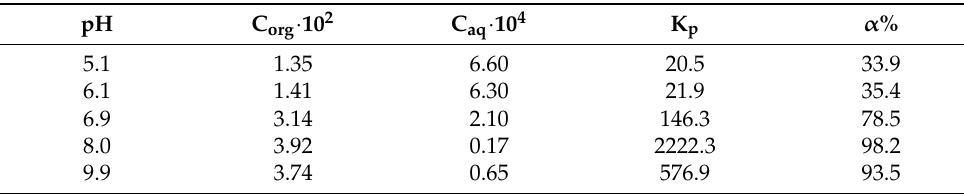
Table 4. Recovery ratio α and distribution coefficient of samarium (III) (process duration was 120 min and C 0 = 0.001